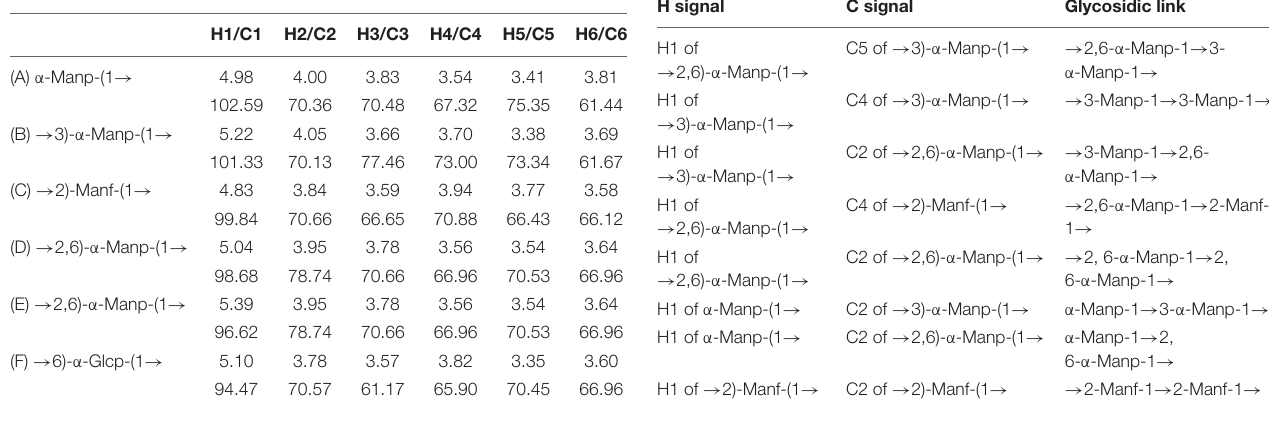
TABLE 3 | Assignments of 1 H and 13 C NMR spectra for S-EPS